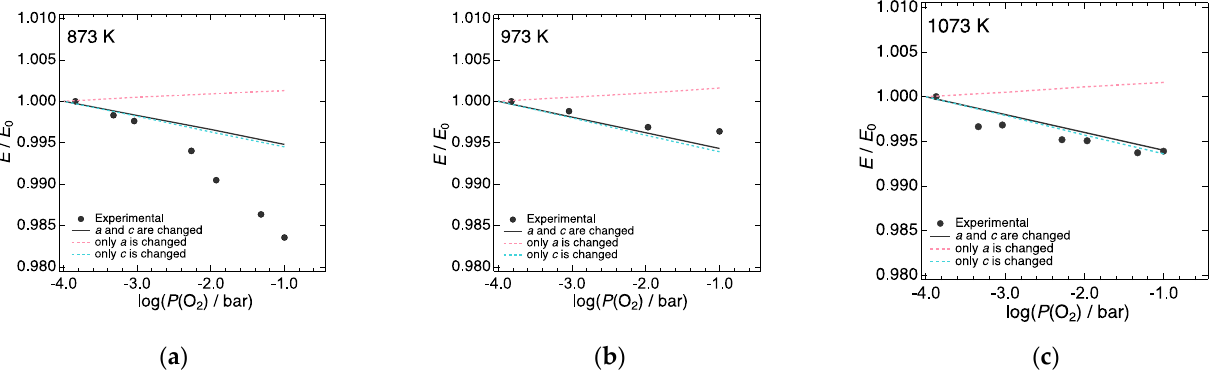
Figure 6. Change in the Young’s modulus of LN214 from the value under a P (O 2 ) of 10 − 4 bar at ( a ) 873, ( b ) 973, and ( c ) 1073 K, respectively. Black circles represent the experimentally observed change. Black lines represent the change in the Young’s modulus, which was calculated under the assumption that a - and c -lattice constants decreased/increased with increasing P (O 2 ), respectively, while the interstitial oxygen concentration remained unchanged. Pink/sky-blue lines represent the change in the Young’s modulus, which was calculated under the assumption that only a or c decreased/increased with increasing P (O 2 ), respectively, while another lattice constant was fixed to the standard value ( a or c under a P (O 2 ) of 10 − 4 bar) and the interstitial oxygen concentration remained unchanged.